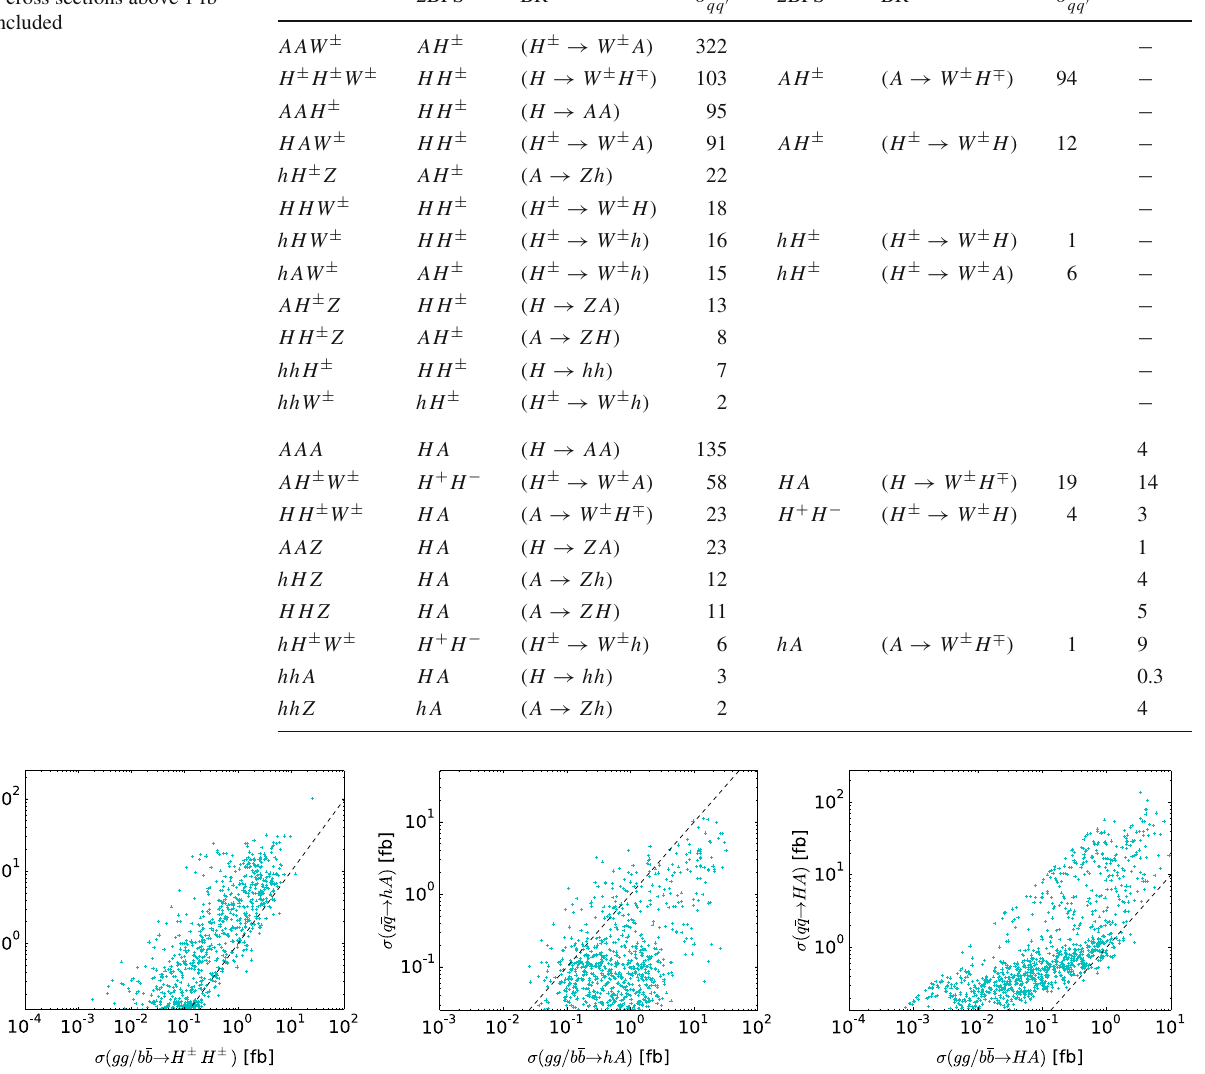
Fig. 3 Neutral 2BFSs for which the cross sections for qq (cid:2) production can exceed those for gg / b ¯ b -initiated processes. The dashed line indicates where the cross sections are of equal magnitude